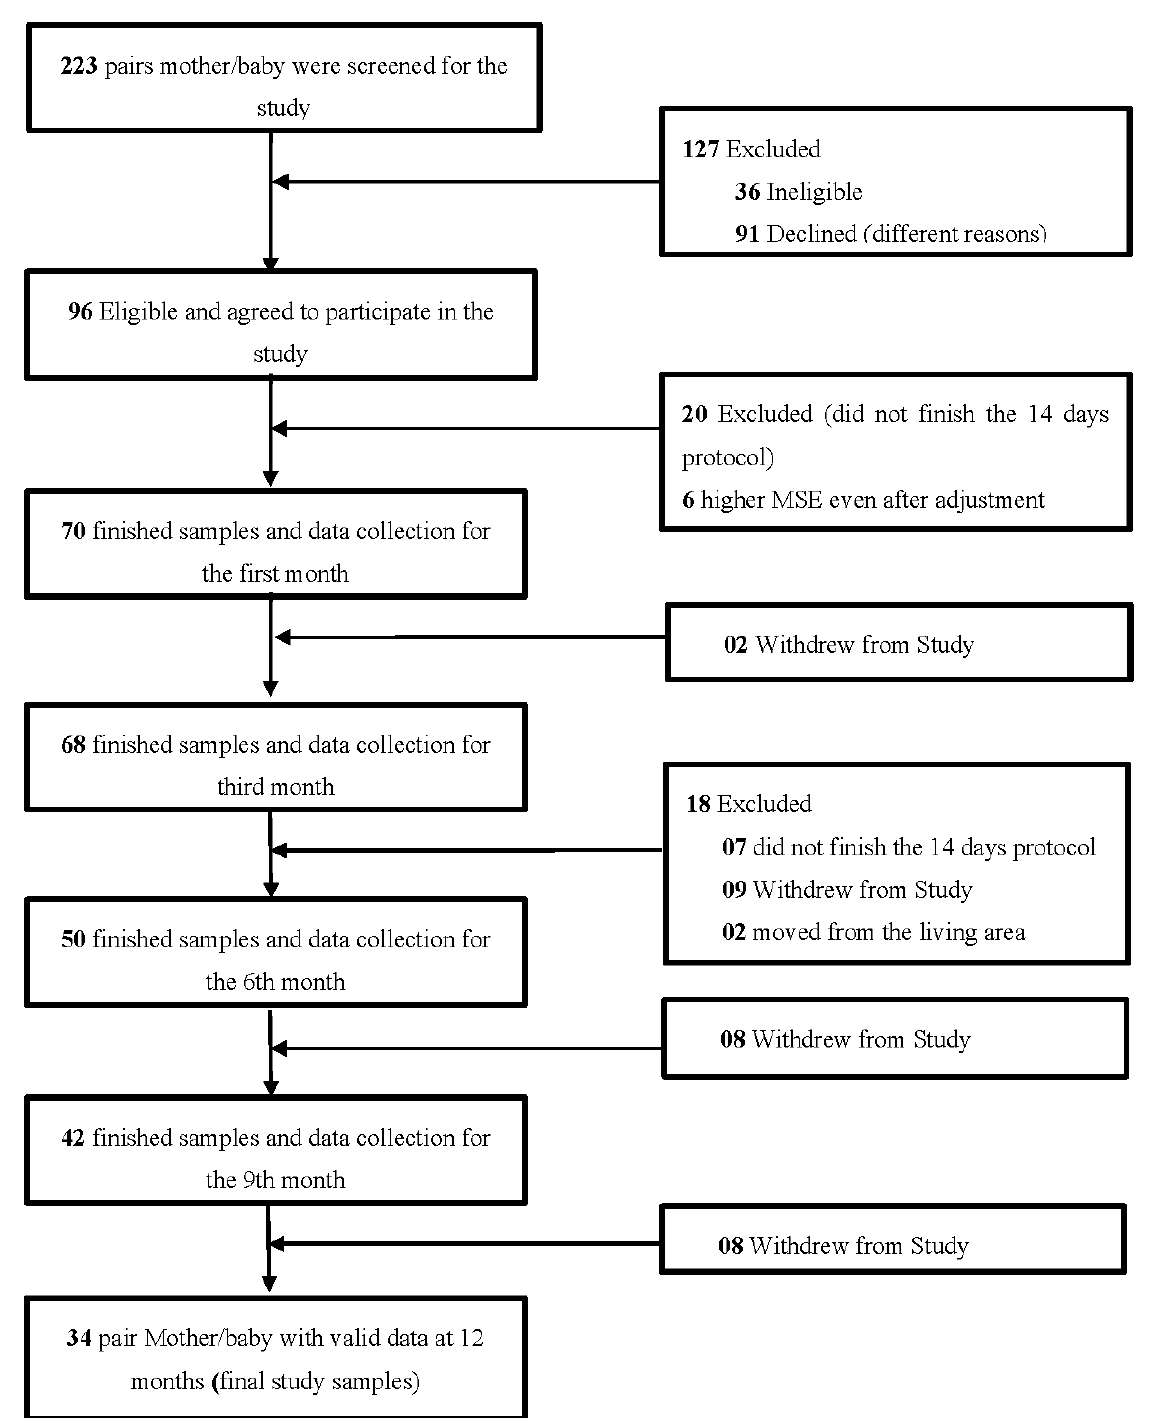
Figure 1. Study recruitment design. For different reasons 62 couples were excluded after their enrolment in the study from which only 27 withdrew.